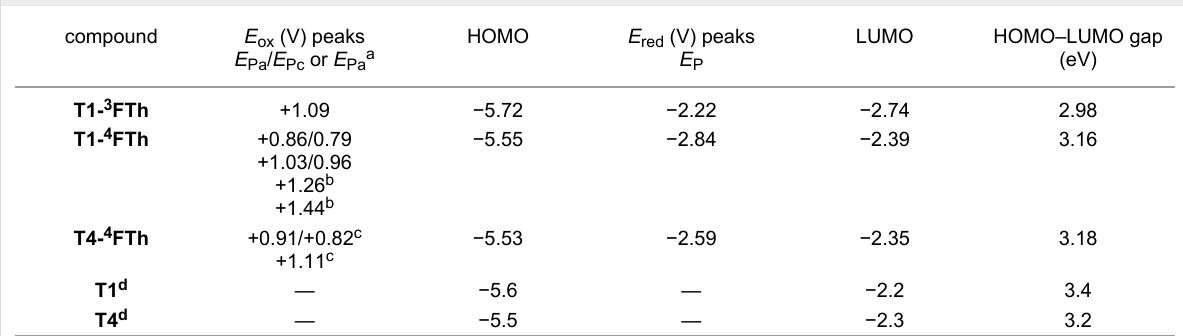
Table 2: Electrochemical data for TX- X FTh and TX .